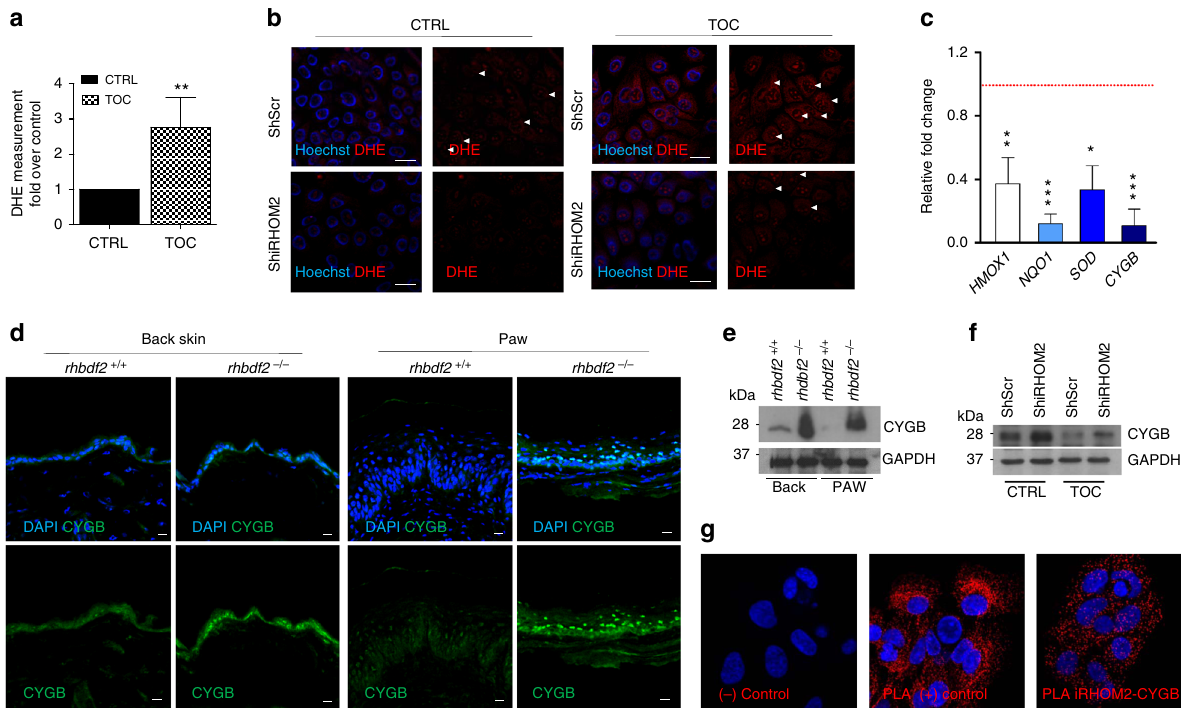
Fig. 5 iRHOM2 regulates oxidative stress in hyperproliferative keratinocytes. a Quanti fi cation of dihydroethidium (DHE) staining in control (CTRL) and TOC keratinocytes by fl ow cytometry. Data are expressed as mean and SEM of three independent experiments. Statistical analysis was performed to compare CTRL and TOC cells using Student ’ s two-tailed t -test (** p < 0.01). b DHE staining (red) in live Sh Scr or Sh iRHOM2-transfected CTRL and TOC keratinocytes by confocal microscopy. Hoechst 33342 (blue) was used to identify nuclei. c qRT-PCR of HMOX1 , NQO1 , SOD and CYGB in TOC keratinocytes was assessed as fold change compared to CTRL cell expression (dashed line). The graph represents means and SEM of three biological replicates. Statistical analysis was performed comparing CTRL and TOC keratinocytes using Student ’ s two-tailed t -test (* p < 0.05, ** p < 0.01, *** p < 0.001). d Immunostaining of CYGB was performed in fore-paw and back skin sections of rhbdf2 + / + and rhbdf2 − / − mice by confocal microscopy. DAPI (blue) is used as nuclear stain. Scale bar: 20 µ m. e Representative WB for CYGB expression from proteins extracted from back skin and fore-paw of rhbdf2 + / + and rhbdf2 − / − mice. GAPDH was used as a loading control. f WB analysis of CYGB in Sh Scr and Sh iRHOM2-transfected CTRL and TOC keratinocytes. GAPDH was used as a loading control. g Representative confocal images from PLA experiments between iRHOM2 and CYGB in control keratinocytes. PLA between K6 and K16 was performed as a positive ( + ) control, while no primary antibodies were applied in negative ( − )